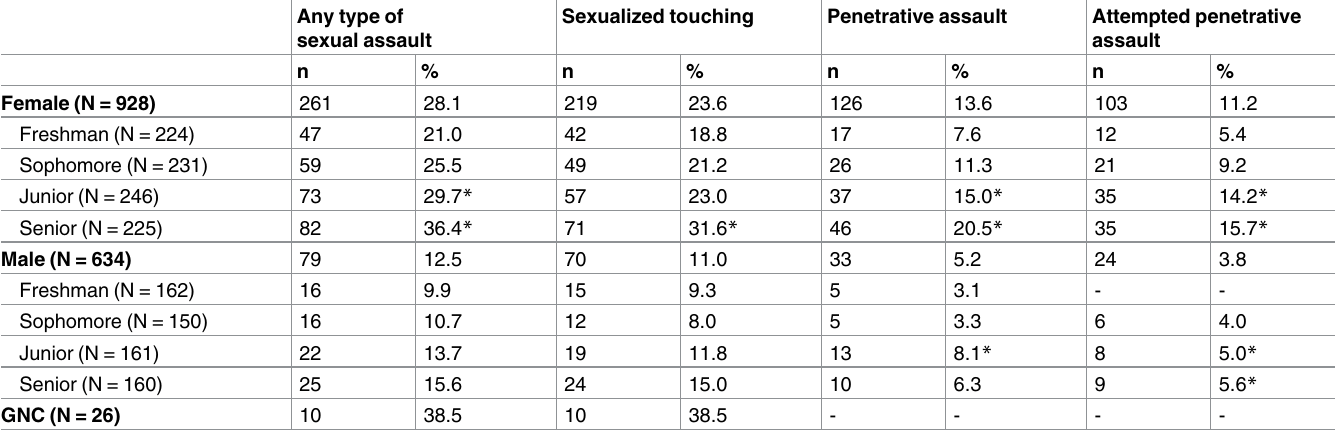
Table 2. Sexual assault since enrolling at CU/BC, by respondent gender and year in school. Any type of Sexualized sexual assault